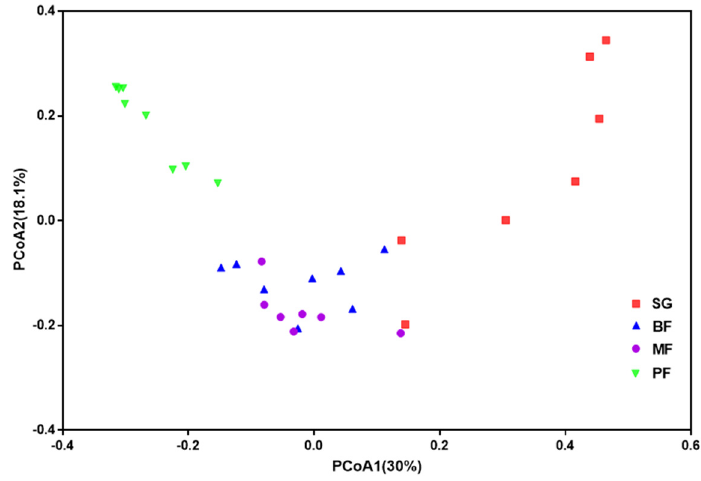
Figure 2. Principal coordinates analysis (PCoA) of Bray–Curtis distances of the bacterial communities among the four succession stages. (R 2 = 0.422, p = 0.001). SG: Shrub-grassland; BF: Broad-leaved; MF: Coniferous broad-leaved; PF: Primary forest. Table 2. Pairwise community dissimilarity test of the soil bacterial communities using analysis of similarity (ANOSIM) based on Bray–Curtis distance.